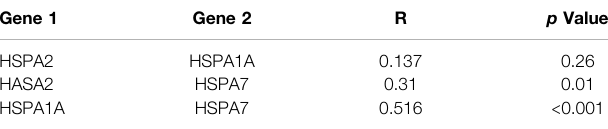
TABLE 7 | The correlation coef fi cient of HSPs in colon